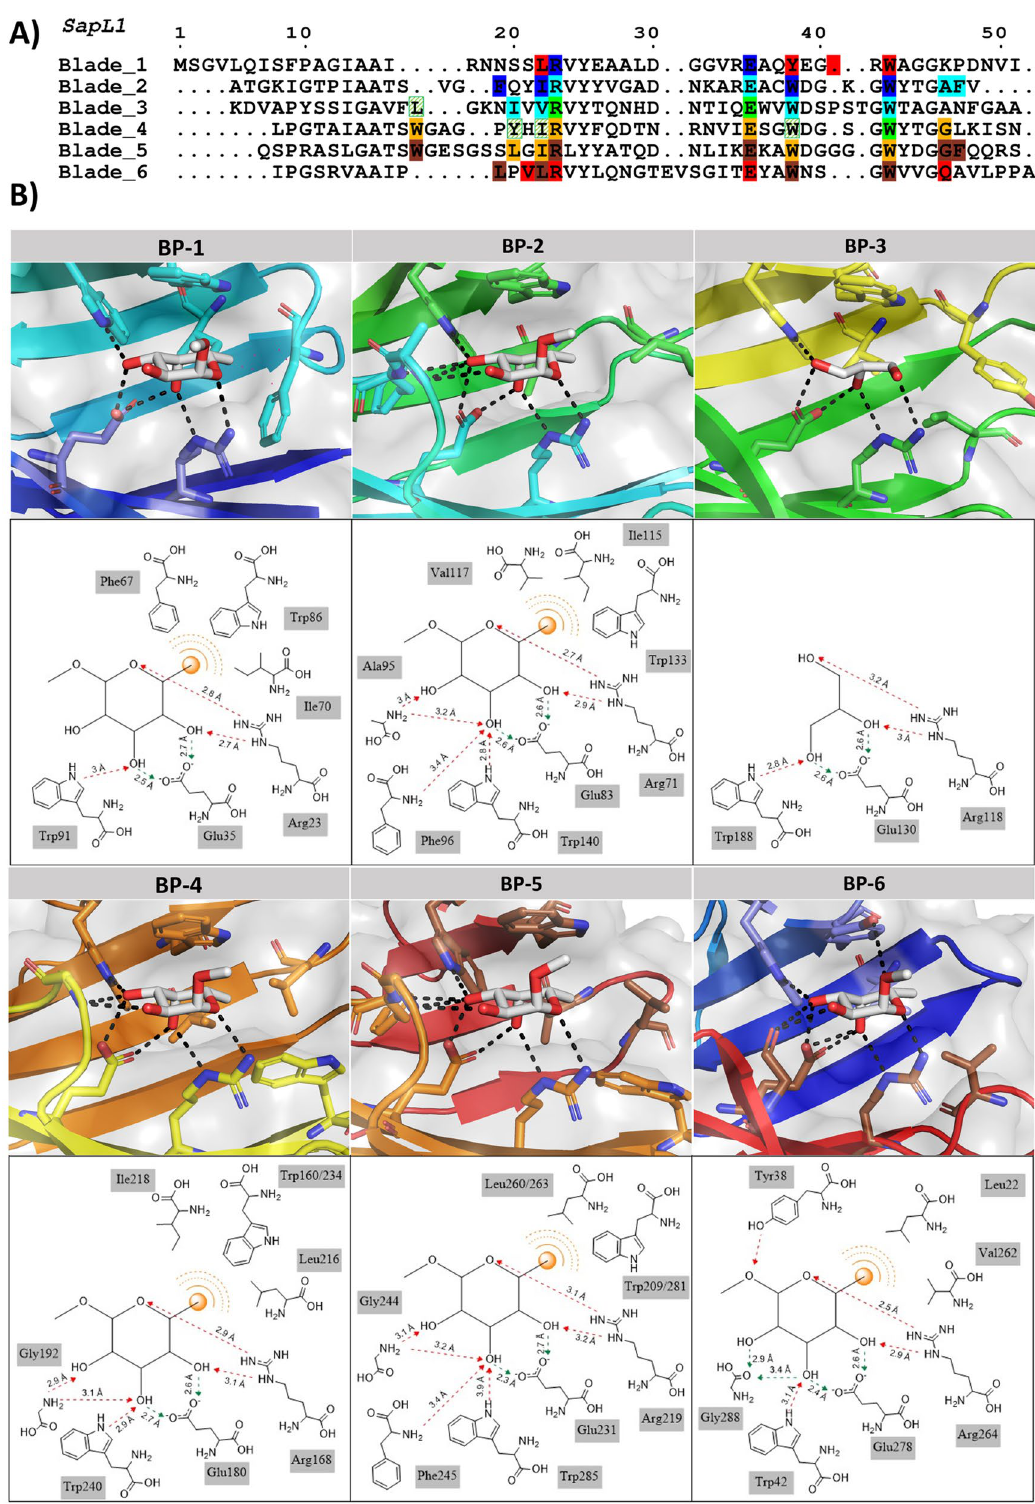
Figure 6. SapL1-ligand interactions. ( A ) The sequence alignment of the 6 blades of SapL1. The residues involved in ligand binding interactions are indicated in solid boxes: BP-1, blue; BP-2 cyan; BP-3 green; BP-4, orange, BP-5, brown; BP-6, red. Striped green boxes indicate the four additional residues expected to be involved in fucose binding within BP-3 that were not visible in the structure since only glycerol was attached to this pocket. ( B ) Zoom on the interactions of ligand with each binding site of SapL1 and their schematic